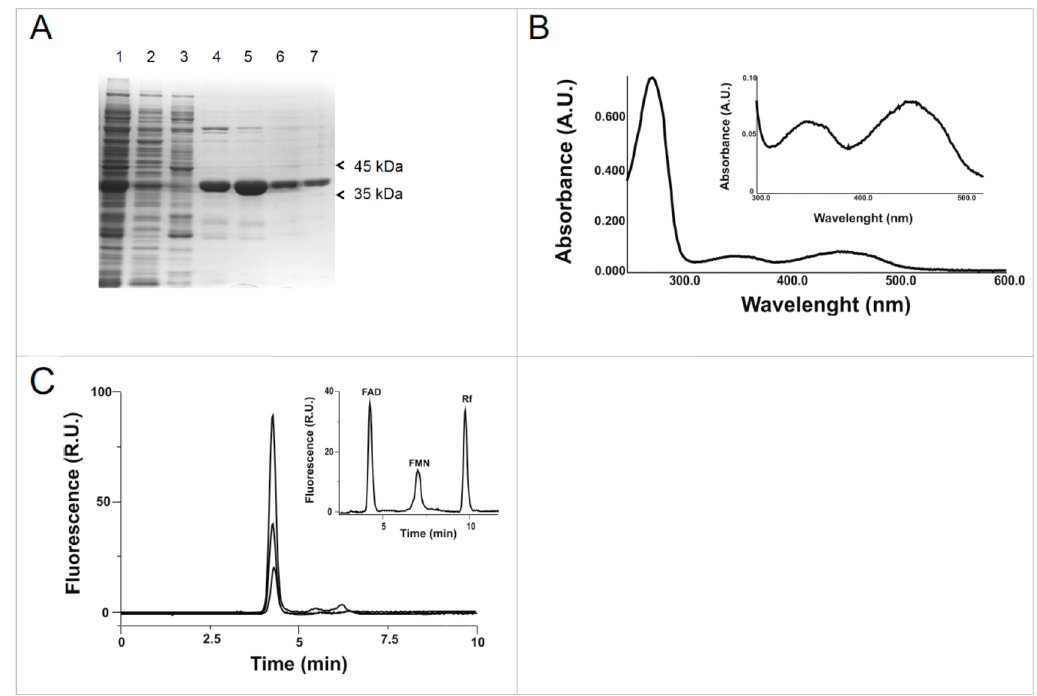
Figure 3. Purification of 6His-hFADS6. ( A ) Protein fractions obtained by Ni 2+ -chelating chromatography were separated by SDS–PAGE on 12% T polyacrylamide gel and stained with Coomassie Blue. Lane 1, soluble fraction of IPTG-induced cell lysate (30 µg); lane 2, first flow-through fraction (10 µg); lane 3, proteins eluted with 50 mM imidazole (8 µg); lane 4, first fraction of proteins eluted with 100 mM imidazole (9 µg); lane 5, second fraction of proteins eluted with 100 mM imidazole (10 µg); lane 6, first fraction of proteins eluted with 250 mM imidazole (5 µg); lane 7, second fraction of proteins eluted with 250 mM imidazole (4 µg); ( B ) Absorbance spectrum of the protein purified to homogeneity (Panel A, lane 7). The spectrum of hFADS6 (11.5 µM) was recorded in 40 mM Hepes/Na, 5 mM β -mercaptoethanol, pH 7.4. In the inset, a zoom in the visible region; ( C ) HPLC analysis of acid-extractable flavin cofactor. The purified protein (15.4 µg in 100 µL, 4 µM) was treated with 10% perchloric acid. The supernatant was neutralized and aliquots (10 and 20 µL) were analyzed for flavin content by HPLC. In the inset, chromatographic peaks of standard aqueous FAD (40 pmol), FMN (10 pmol) and riboflavin (10 pmol) solutions are shown for comparison.